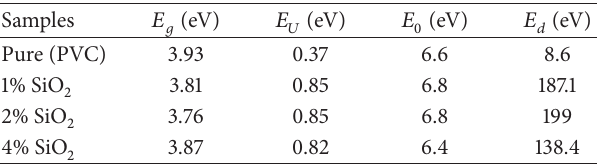
Table 1: The direct energy band gap, 𝐸 𝑔 , Urbach energy, 𝐸 𝑈 , and various optical dispersion parameters for pure PVC and PVC/SiO 2 nanocomposite